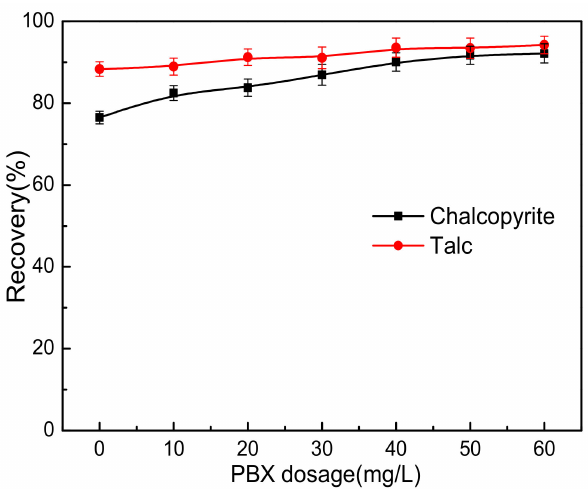
Figure 3. Effect of PBX dosage on the flotation of chalcopyrite and talc (c(MIBC) = 0.125 mL/L, pH = 8).